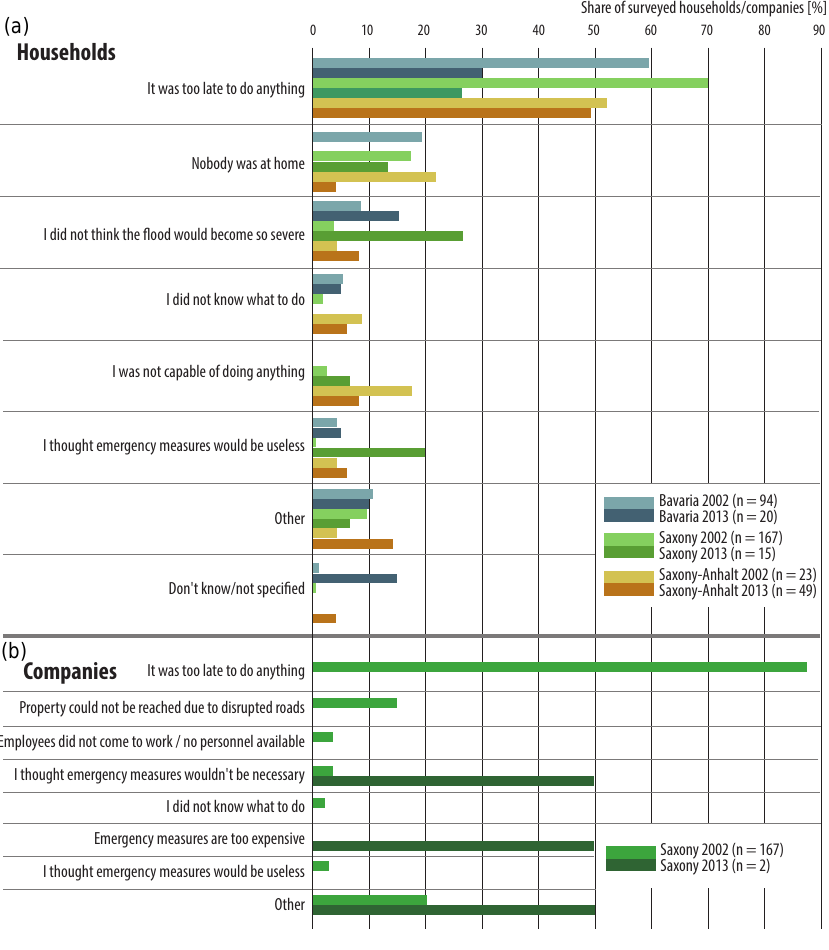
Figure 6. Reasons stated by households (a) and companies (b) in response to the question of why they had not performed any emergency measures (multiple answers